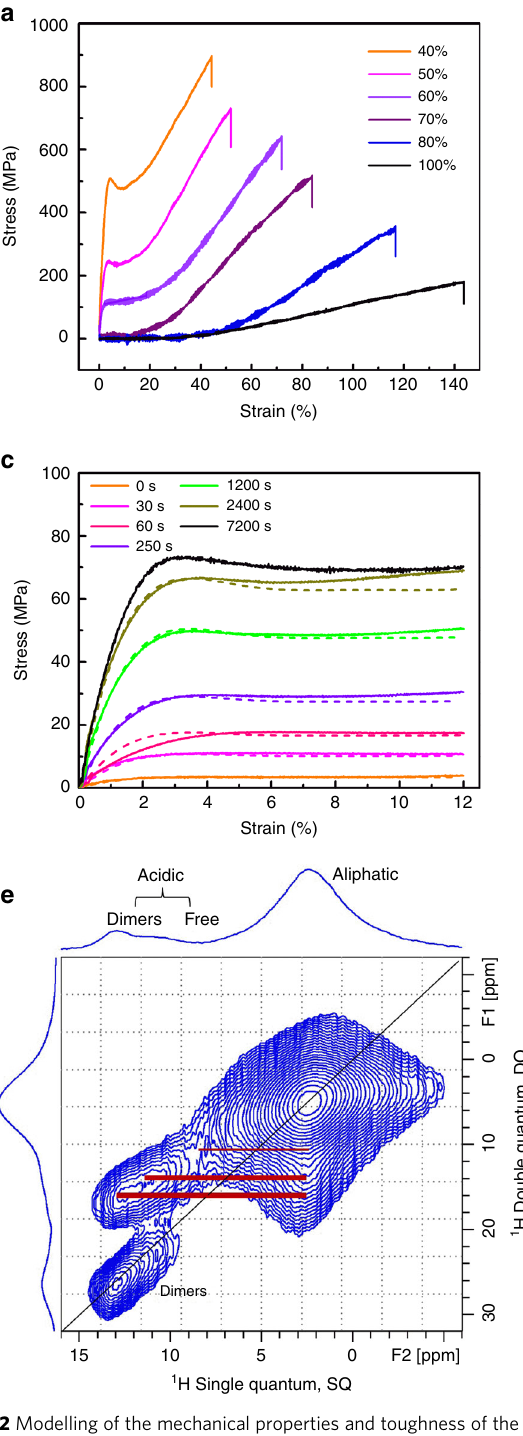
NATURE COMMUNICATIONS| (2019) 10:5293